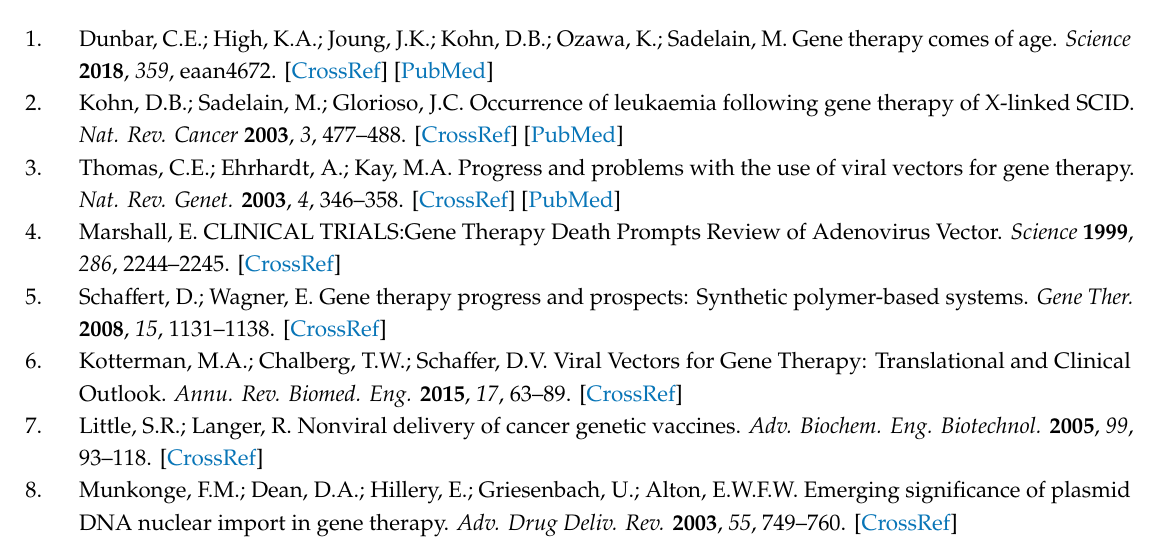
Figure S1: Calibration curve showing the dependence of the fluorescence intensity ( λ ex = 550 nm, λ em = 570 nm) of the solution on the concentration of Cy3-oligo-dT-dA, plotted to determine the amount of encapsulated oligonucleotide as well as to quantify its release; Figure S2: A calibration curve showing the linear dependence of the optical density of the solution on the concentration of the photosensitive linker. The curve was plotted to determine the content of unbound linker upon conjugation with PLL. The absorption was measured at a wavelength of 325 nm. The molar extinction coe ffi cient was estimated as ε = 619 L · mol − 1 · cm − 1 ; Figure S3: The scheme of the installation for irradiation of IPECs with a 325 nm laser; Figure S4: Calibration curve showing the dependence of the optical density of the solution on the concentration of 3-nitro-4-formylbenzoic acid, plotted to determine the amount of released decomposition product, which entered into a qualitative reaction with Schi ff ’s reagent. The absorption was measured at a wavelength of 550 nm. The molar extinction coe ffi cient was estimated to be ε = 1521 L · mol − 1 · cm − 1 ; Figure S5: Reaction of linker decomposition aldehyde product with Schi ff ’s reagent (A); colour reaction with Schi ff ’s reagent, used for photo-colormetric quantification of the reaction; Figure S6: Agarose gel electrophoresis: (1)—ladder; (2,3)—pDNA; (4)—pLys + pDNA; (5)—pLys + pDNA + 4xHep; (6)—pLys + pDNA + 8xHep; Figure S7: The 1 H NMR spectrum of 4-(((2-((tert-butoxycarbonyl)amino) ethyl)amino)methyl)-3-nitrobenzoic acid; Figure S8: Linker (4-(((2-((tert-butoxycarbonyl)amino)ethyl)amino)methyl)-3-nitrobenzoic acid decomposition under UV radiation at λ = 325 nm; Figure S9: Di ff erences in the 1 H NMR spectra of the initial linker (A,C) and its photodestruction product (B,D) when irradiated with a laser with a wavelength of 325 nm with a power of 3 W / cm 2 for 15 min. The signal of aldehyde (B) and hemiacetal (D) groups were detected. Spectra were obtained in DMSO-d6; Figure S10: Stability of IPECS: particles hydrodynamic diameter (A) and ζ -potential (B) change with time. Conditions: 0.1 M PBS bu ff er solution, pH 7.4; particles concentration 0.1 mg / mL, 37 ◦ C; Figure